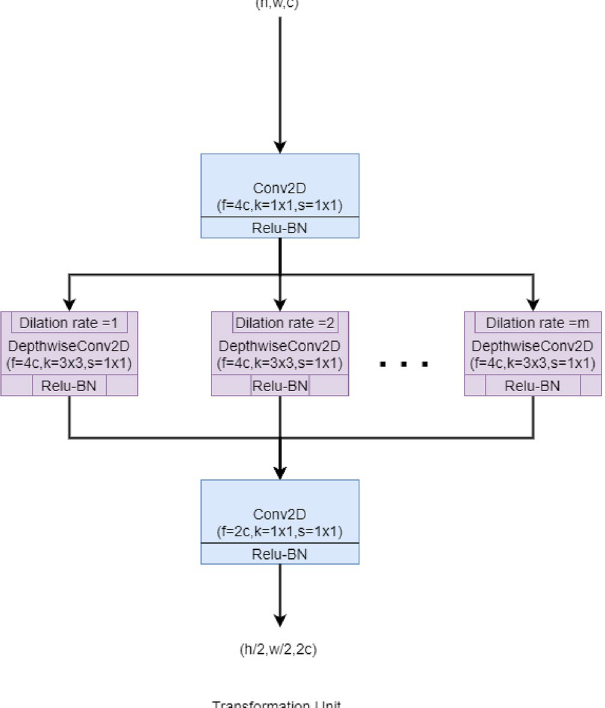
Figure 5. The basic block diagram of the Transformation Unit of the proposed IRFacExNet model. Image is developed using Draw.io 32